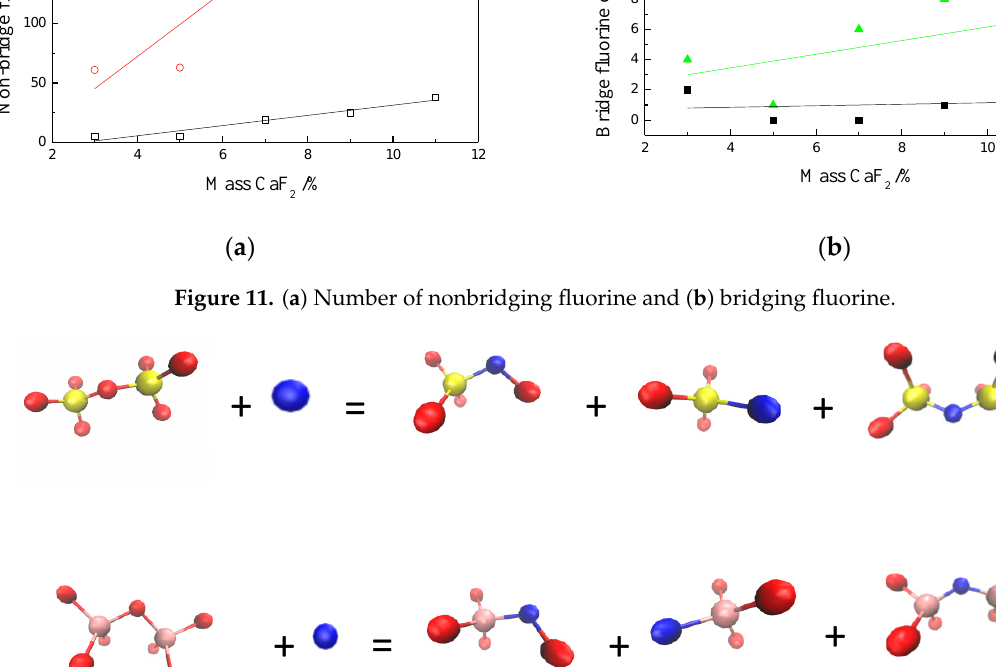
Figure 12. Disintegration of silicate and aluminate structures by fluorine ions.